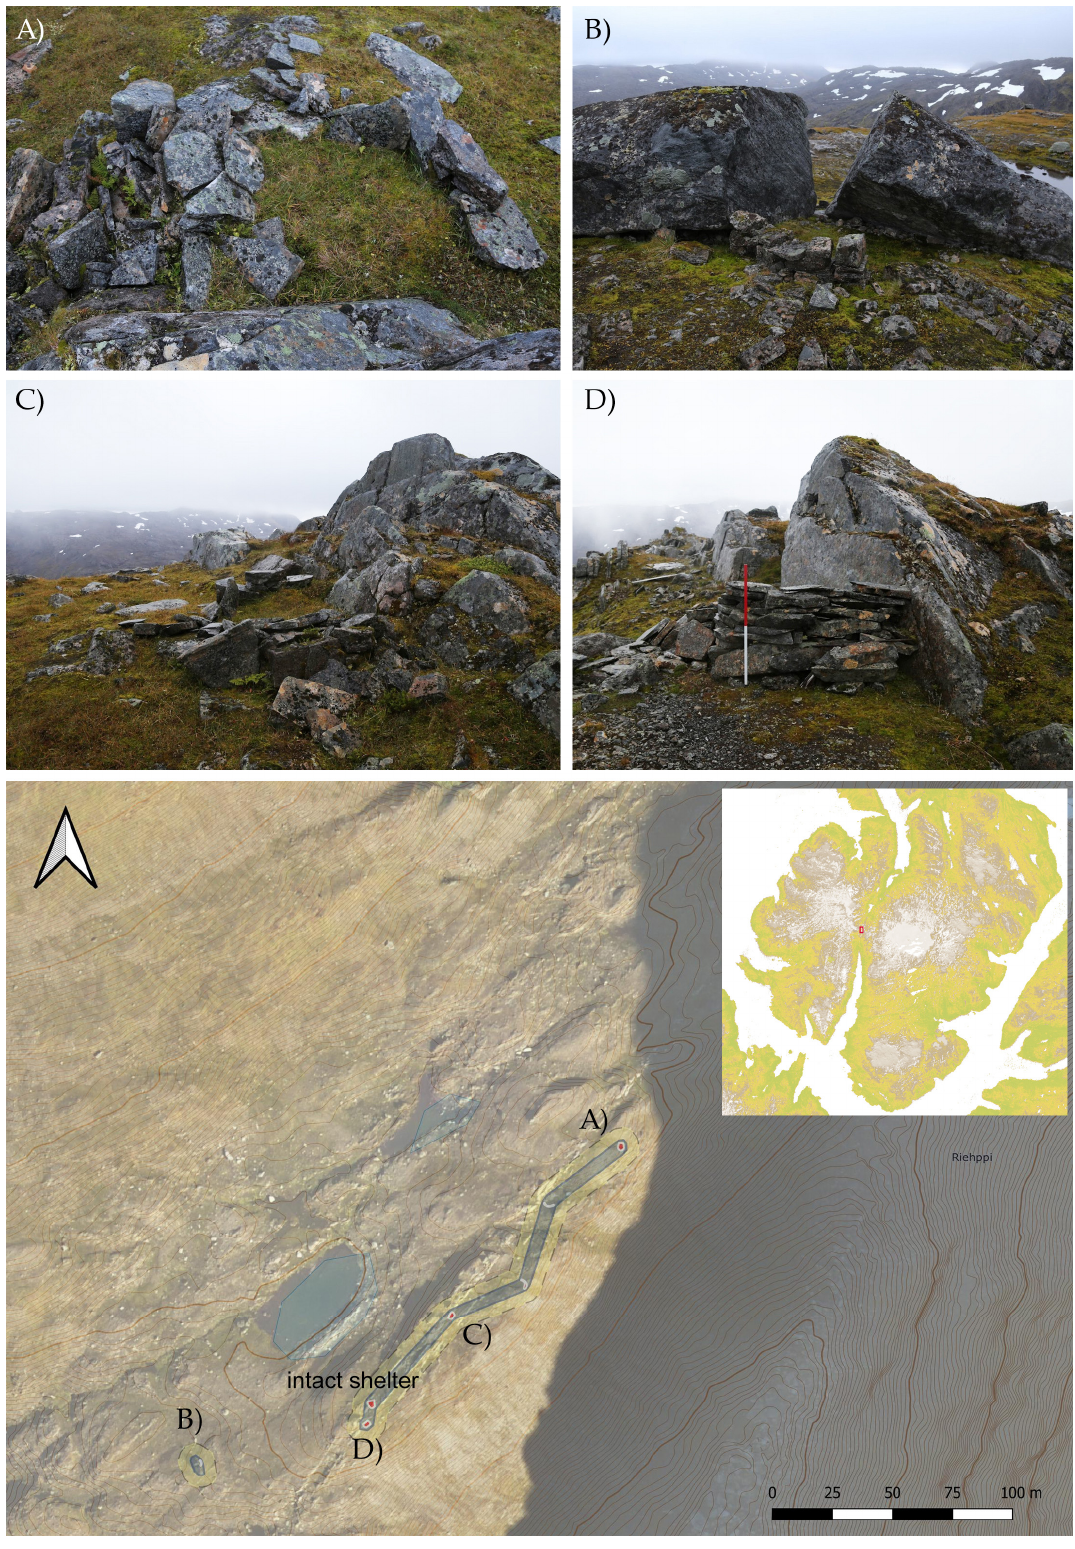
Figure 8. Different stone structures on top of the pass likely related to sheltering or possibly hunting (photographs by G. Caspari). Test pits were excavated in structure ( A ) and structure ( C ). Structure ( D ) seemed to be of recent origin and comparatively loosely assembled. Structure ( B ) might be a shelter but could also be related to Sami ritual or herding-related activity. The intact shelter is depicted in Figure 7.